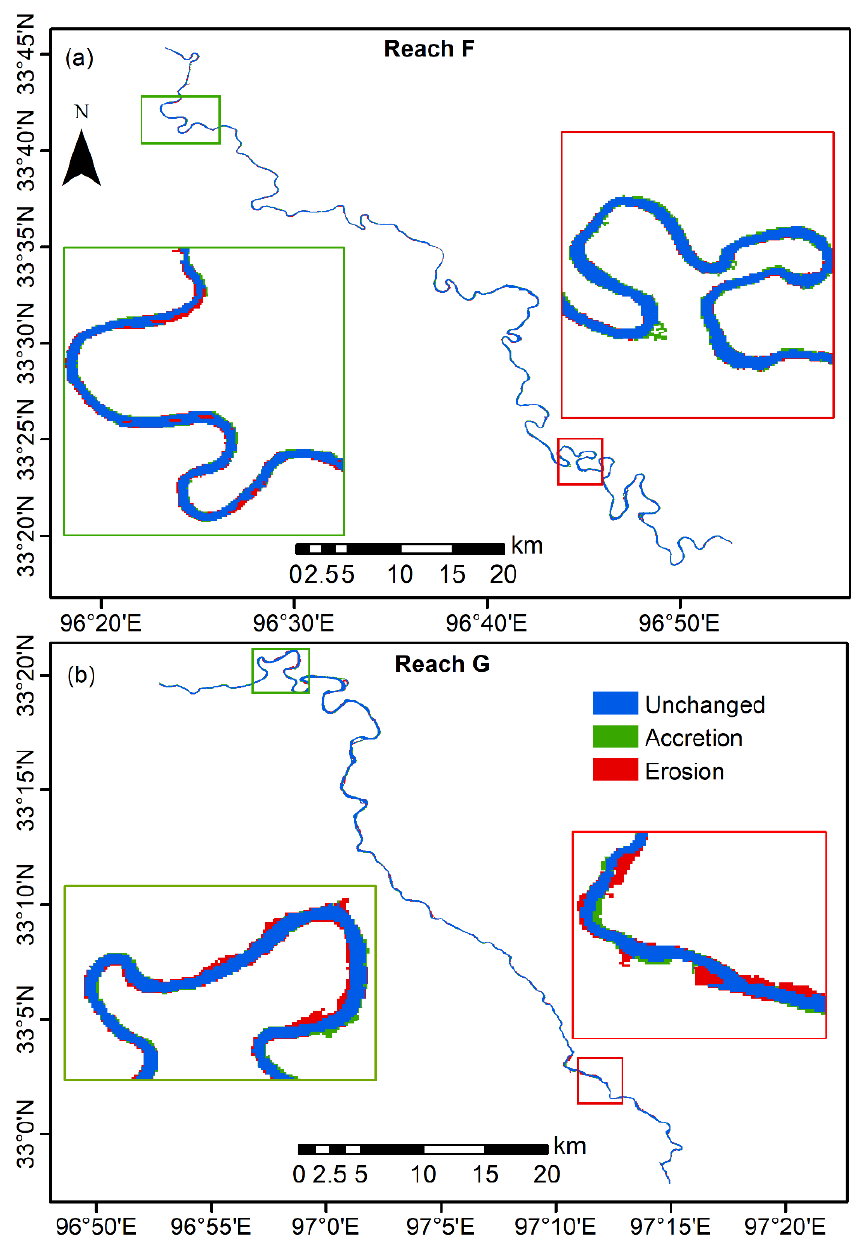
Figure 8. The same as Figure 6, but for the minor meandering reaches F ( a ) and G ( b